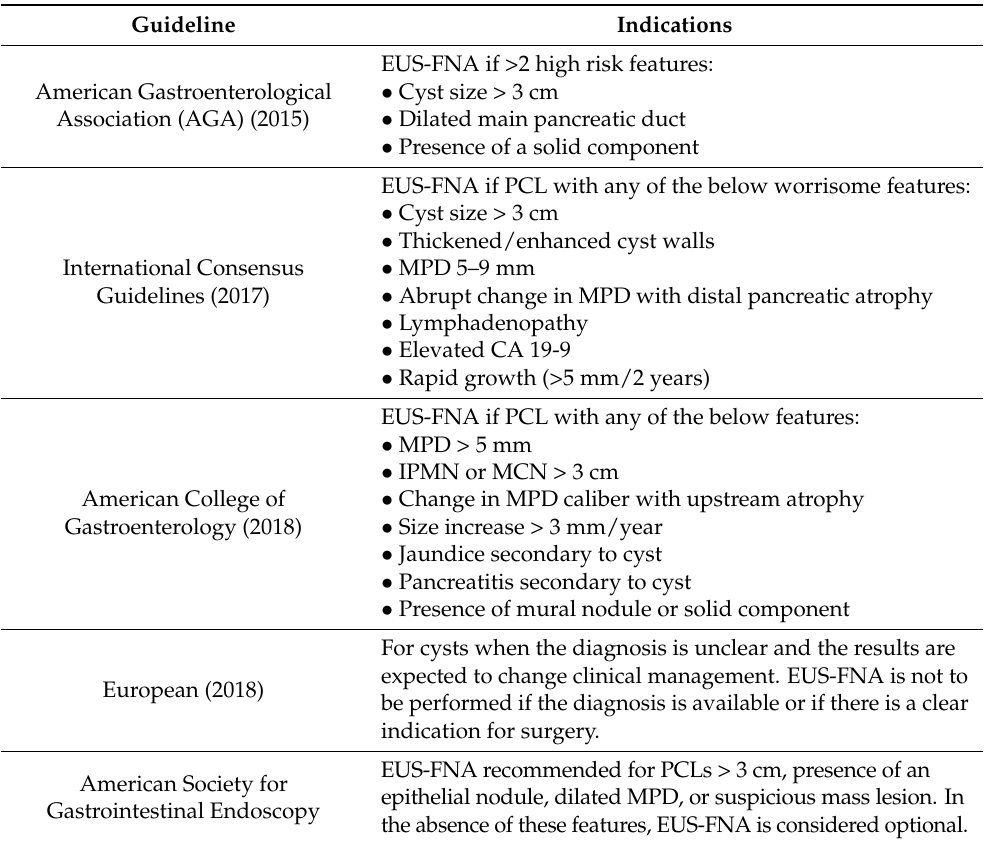
Table 3. Indications for Endoscopic Ultrasound Cyst Fluid